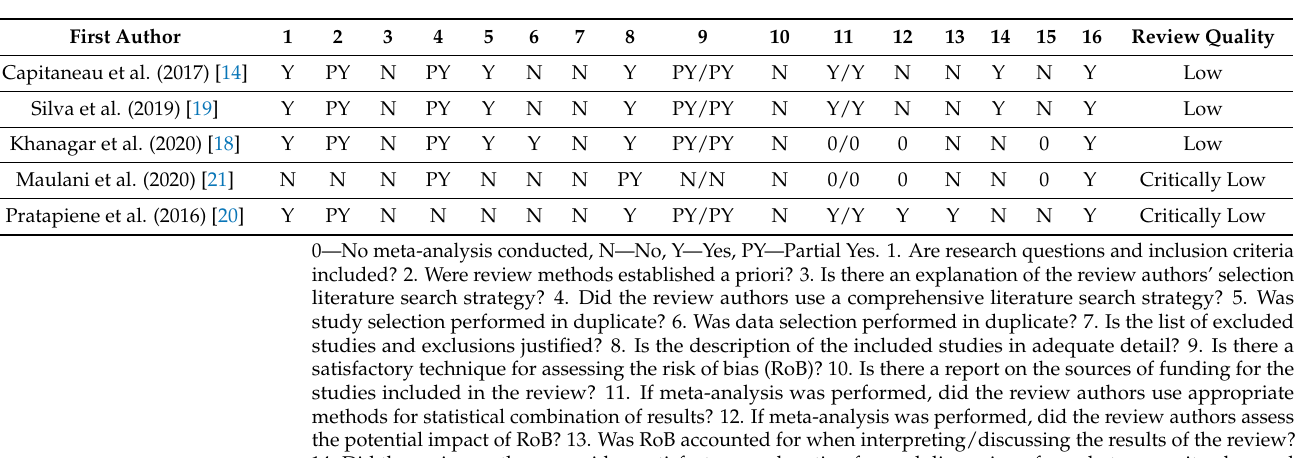
Table 2. Methodological quality of the included